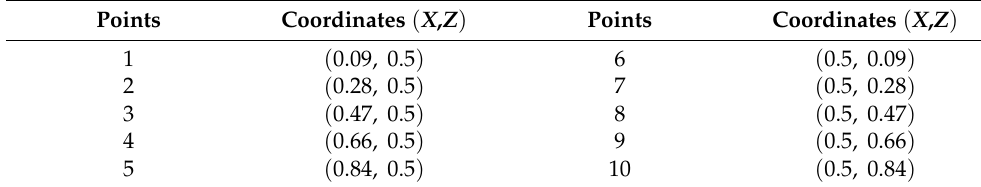
Table 2. Positions of ten measuring lines.